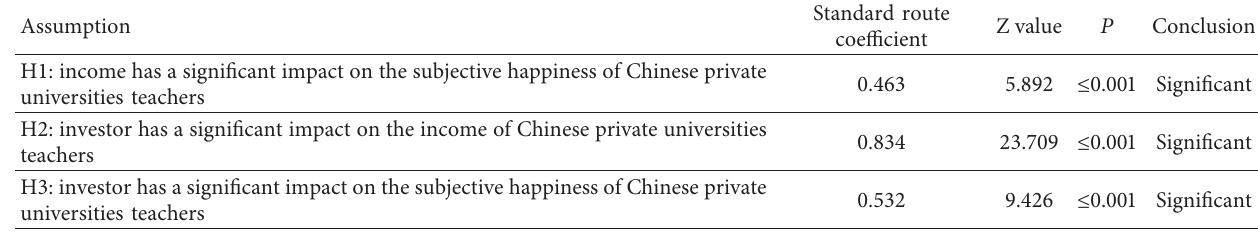
Table 5: Assumption test result analysis.